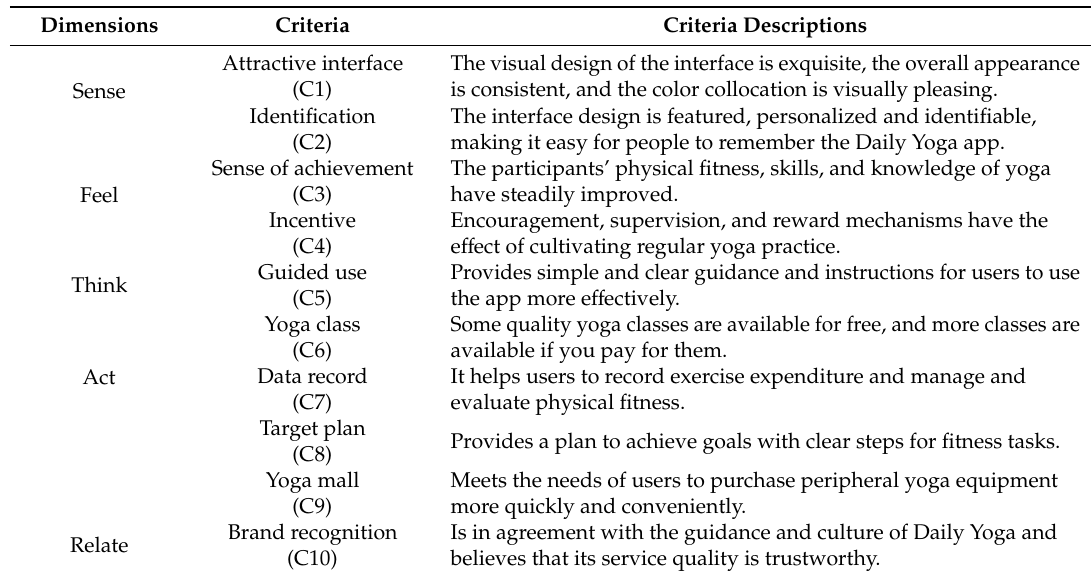
Table 3. Descriptions of the revised assessment